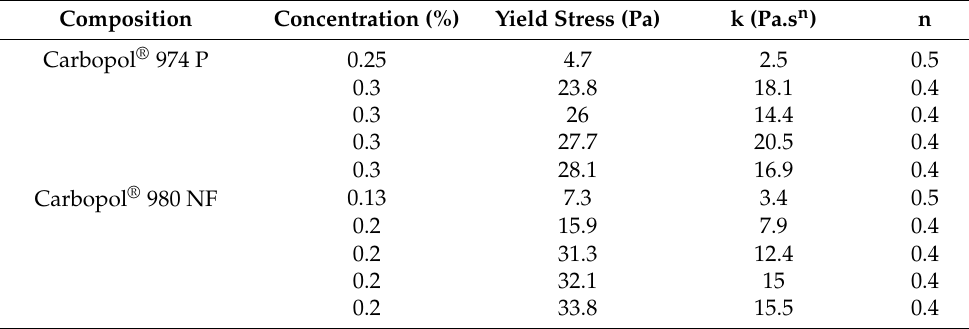
Table 1. Results for gel tear substitutes at 25 ◦